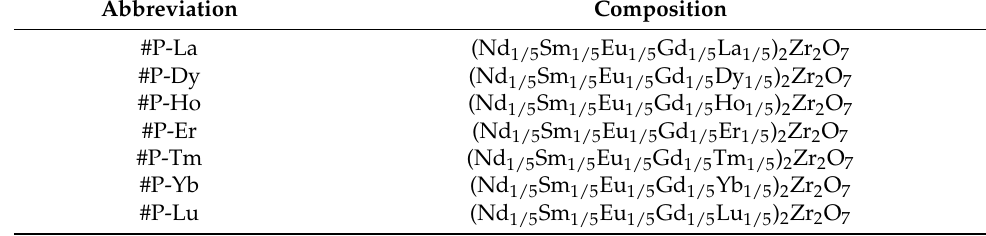
Table 1. Composition and corresponding abbreviation of the seven high-entropy pyrochlore oxides.